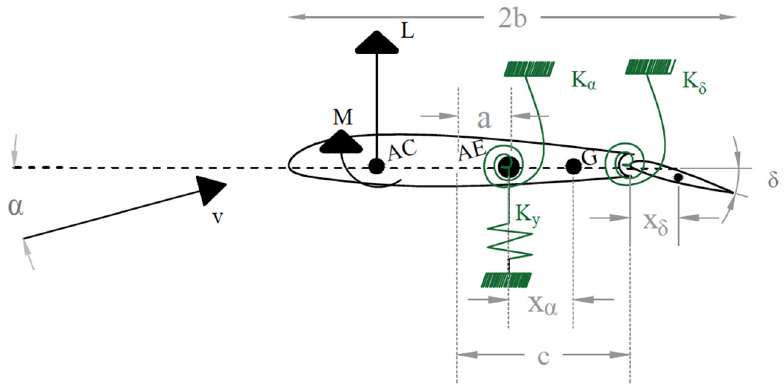
Figure 1. Three-degrees-of-freedom (3DOF) airfoil concentrated parameters model.